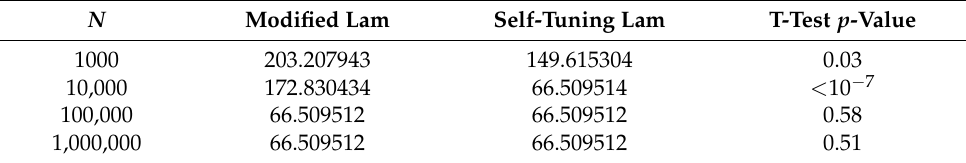
Table 13. Average solution for minimizing f 2,100 ( x ) . The minimum is f 2,100 ( x ) ≈